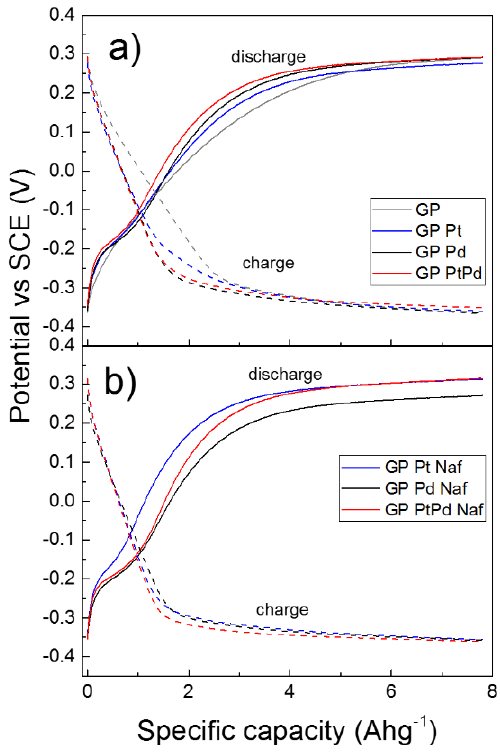
Figure 8. ( a ) galvanostatic charge and discharge curves of GP and NPs-GP; ( b ) galvanostatic charge and discharge of NPs-GP obtained by suspension in water 025% wt. Nafion. Conditions: KOH 1 M; current 100 µ A. The specific capacity was calculated with respect to the mass of 1 cm 2 of current 100 μA. The specific capacity was calculated with respect to the mass of 1 cm 2 of GP.